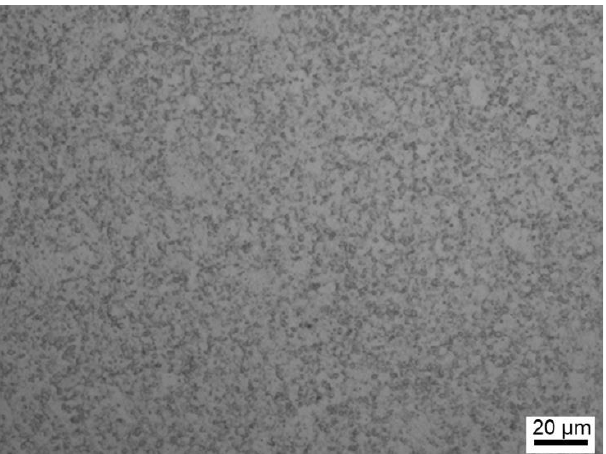
Figure 1. The microstructure of PM superalloy before heat treatment taken by optical microscopy.